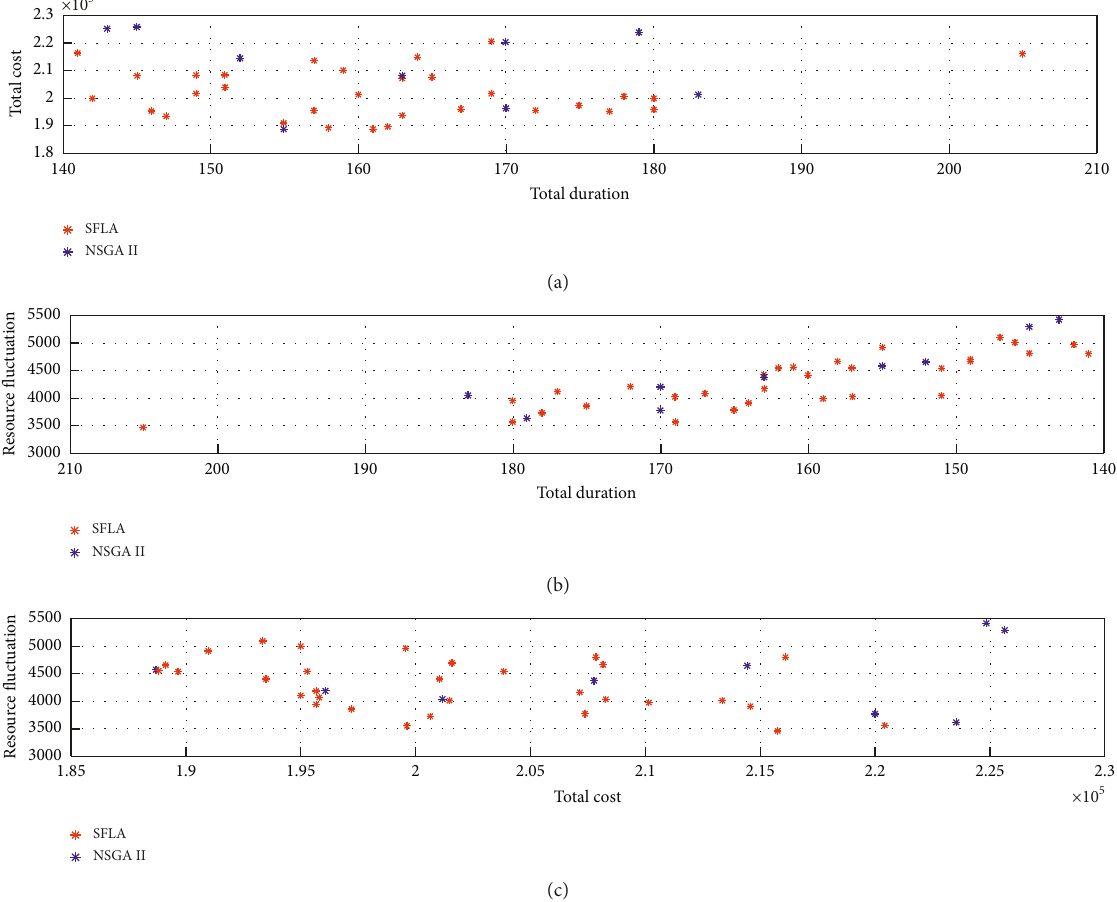
Figure 11: Solution comparison in two-dimensional